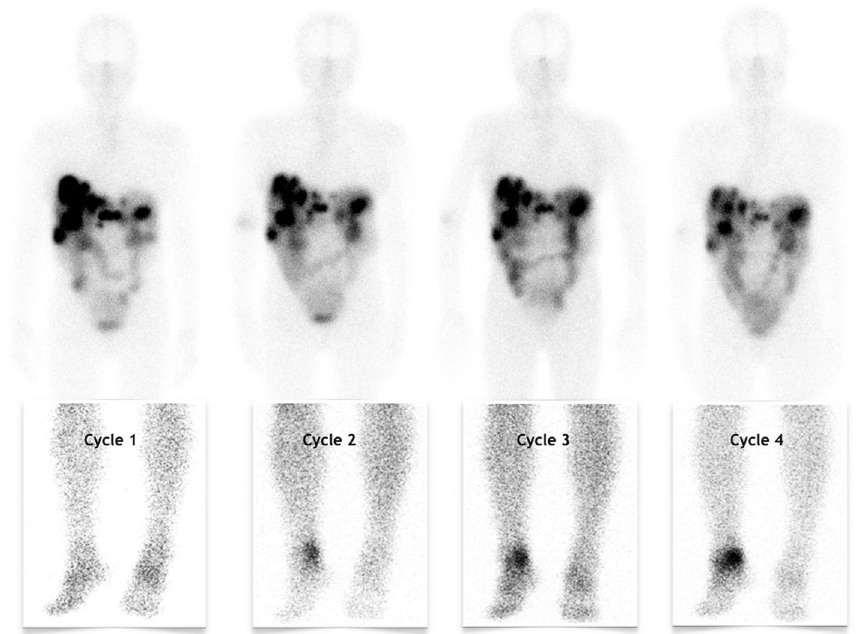
Fig. 2 Whole body planar scintigraphy images in the anterior view 2-days post PRRT with zoom images below showing increasing uptake in the right ankle from cycle 2 to